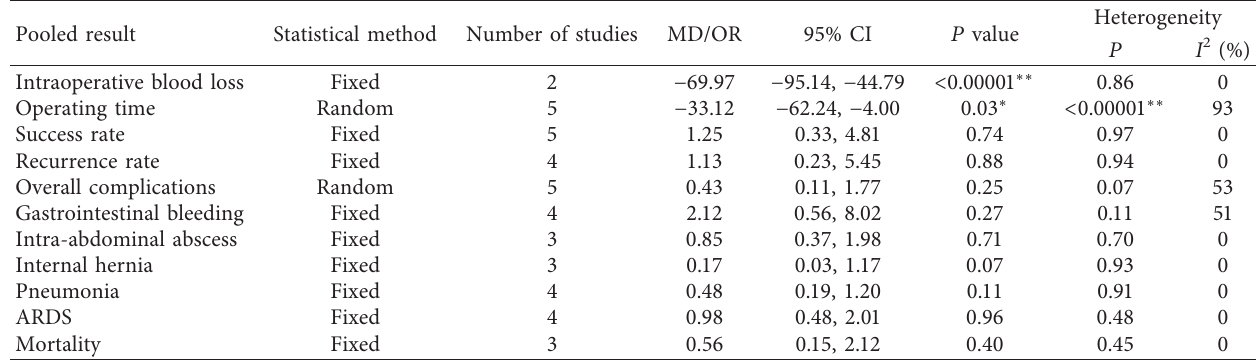
Table 2: Summary of pooled